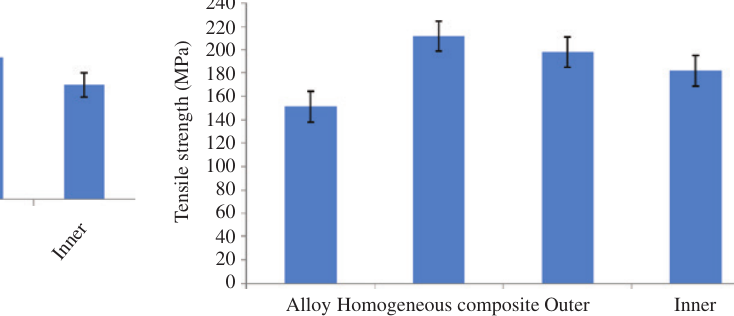
Figure 6: Hardness of the alloy and the composite surfaces. Figure 7: Tensile strength of the alloy and the